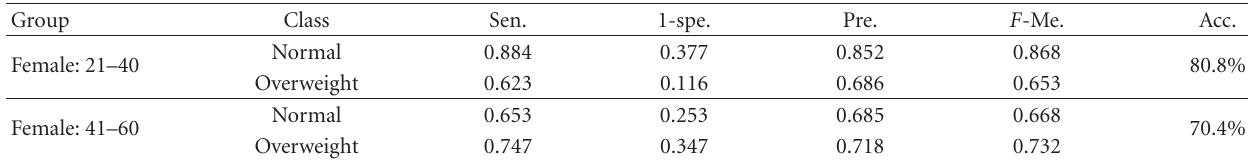
Table 3: Detailed performance evaluation of experiments using the MDL method in 2 groups (Sen.: sensitivity, 1-spe.: 1-specificity, Pre.: precision, F -Me.: F -measure, and Acc.: accuracy).